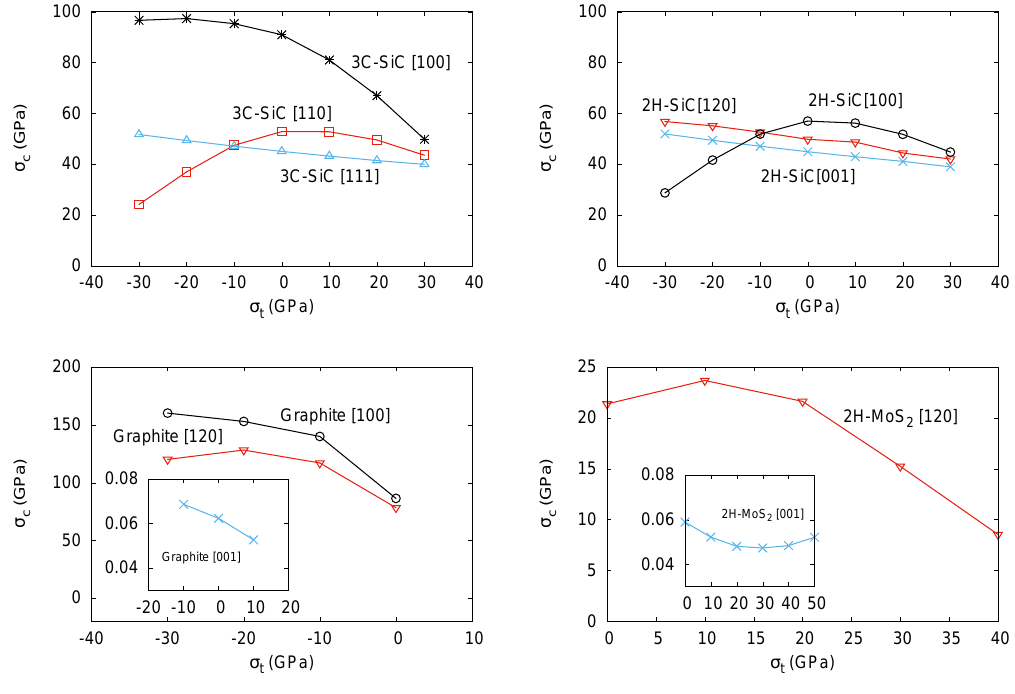
Figure 2. Calculated critical stress-transverse stress curves for: 3C-SiC ( top left ), 2H-SiC ( top right ), Graphite ( bottom left ), and 2H-MoS 2 ( bottom right